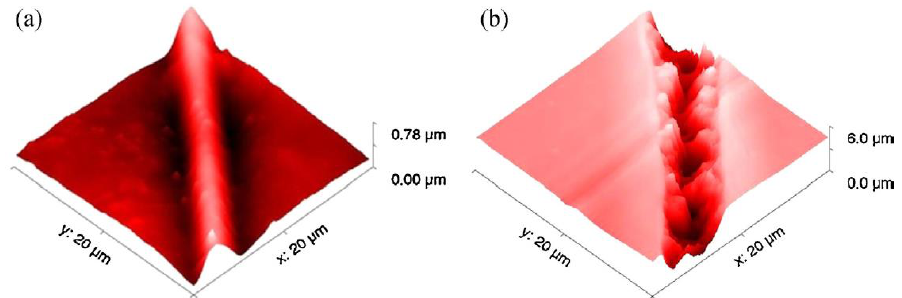
Figure 4. Sample topography from Atomic Force Microscopy (AFM) of structures induced on MEH-PPV film by using laser pulse energy of 0.6 nJ ( a ) and 1.1 nJ ( b ) at scanning speed of 25 μm/s. Reprinted with permission from [56]. Copyright (2014) Elsevier.